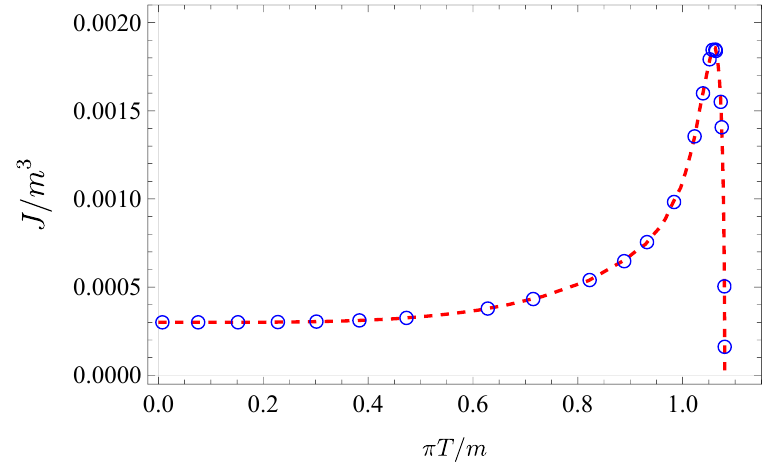
= 0 and temperature T (the blue open ⊥ = 0 in figure 14. The red dashed line ⊥